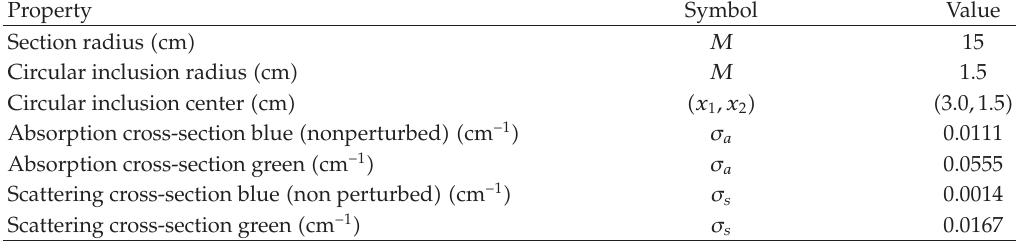
Table 1: Absorption and scattering coe ffi cient in the transillumination model.